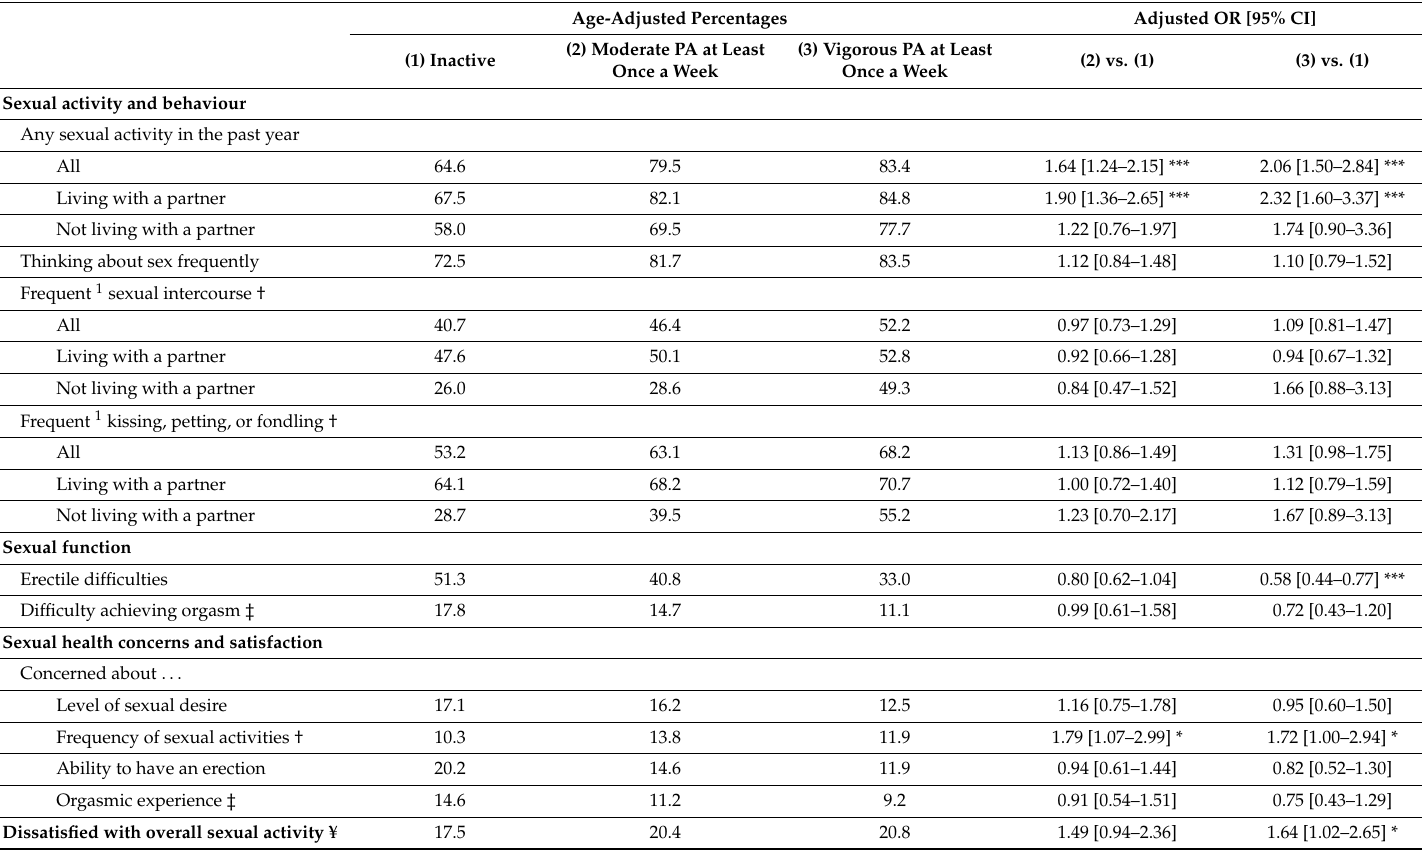
Table 2. Sexual activities, functioning and concerns in relation to physical